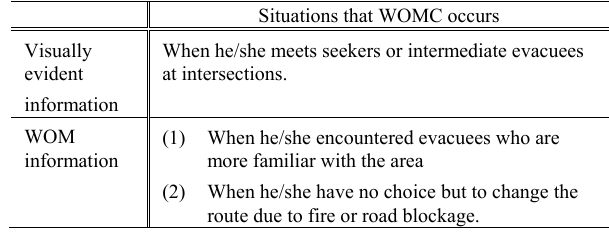
Table 3. Timing and details of WOMC